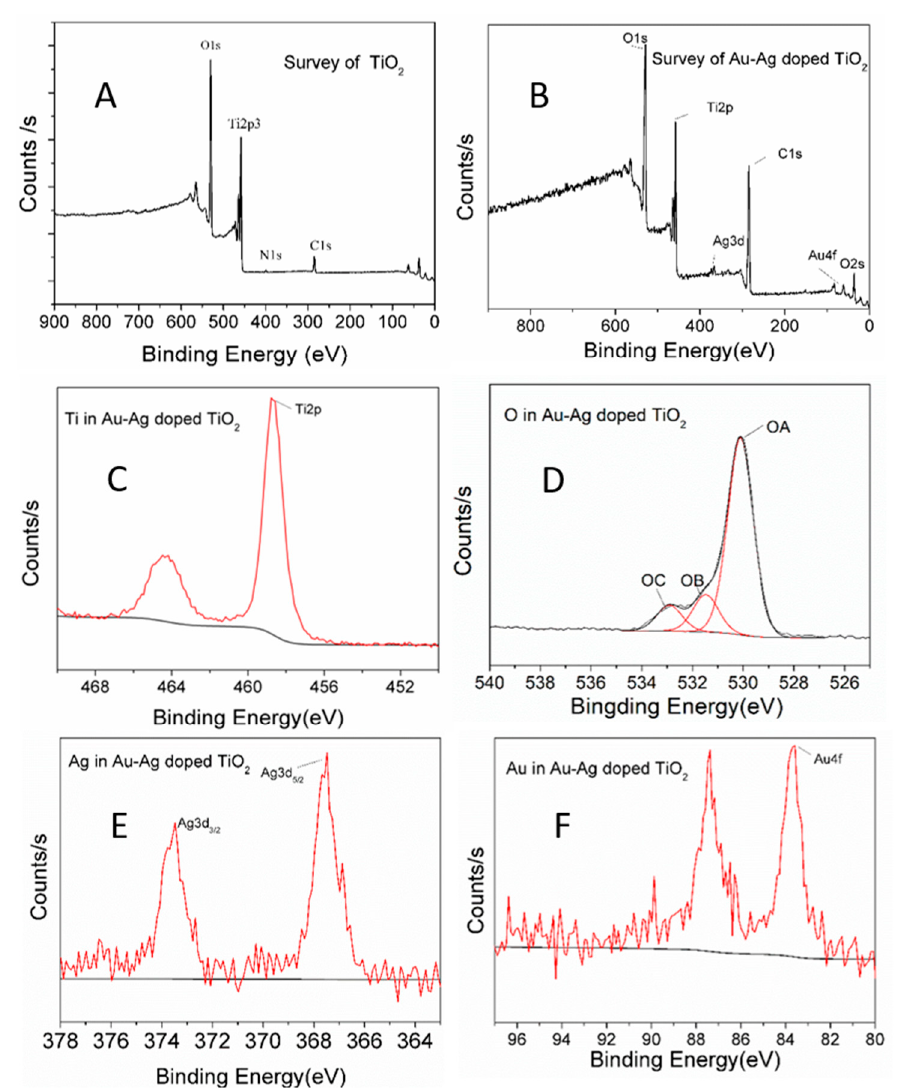
Figure 4. ( A ) XPS spectra of the as-prepared pure TiO 2 particles, and ( B ) Au-Ag-decorated TiO 2 particles (Au x Ag (1 − x ) /TiO 2, x = 0.6); ( C – F ) XPS elemental spectra for Ti2p3, O 1s, Ag3d and Au4f in Au-Ag decorated TiO 2 particles.